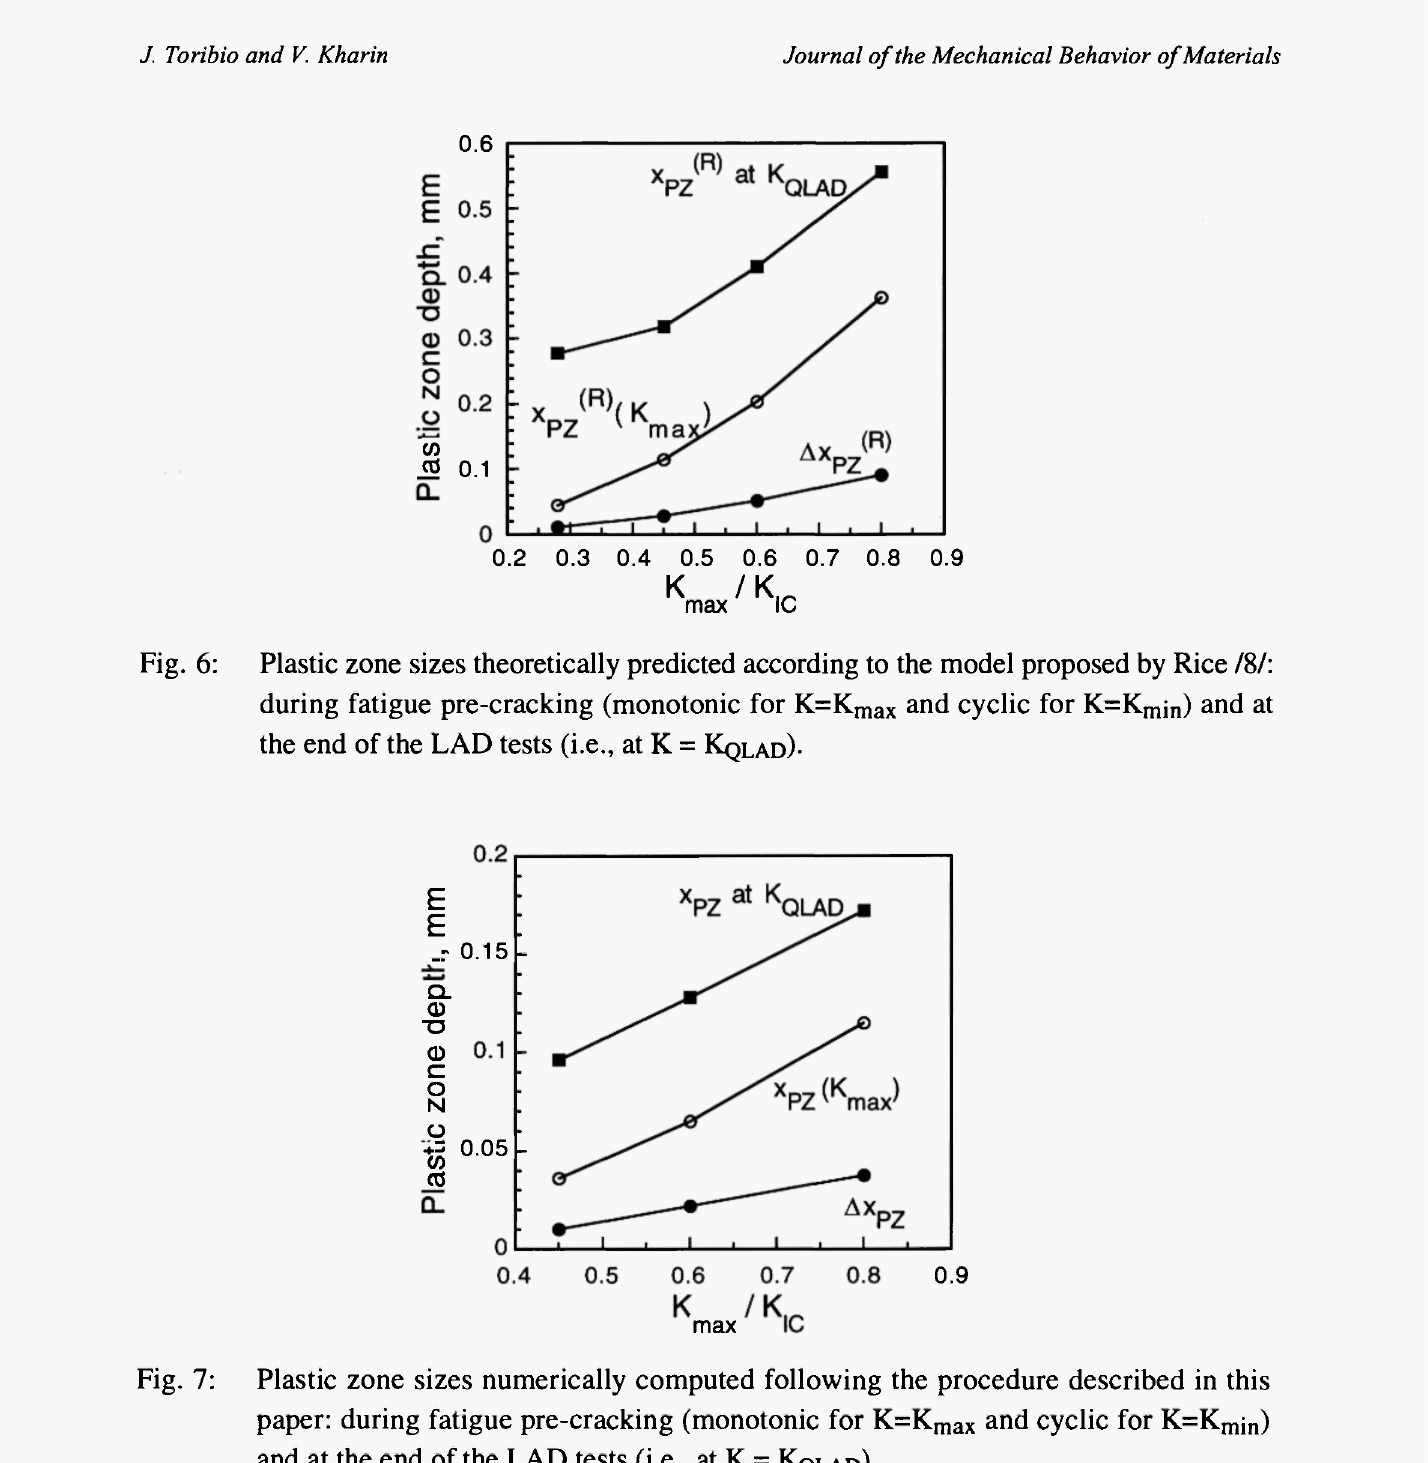
and cyclic for K=K m ax m j n )